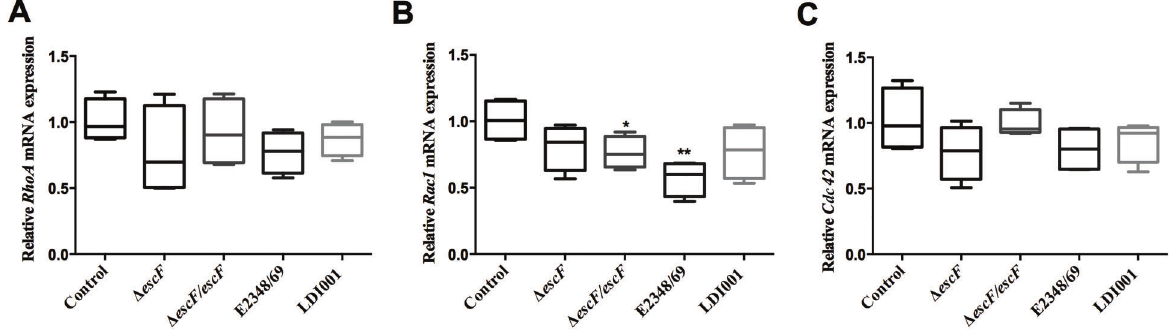
Figure 4. Expression of the transcription of small Rho GTPases RhoA ( A ), Rac1 ( B ), and Cdc42 ( C ) by IEC-6 cells after infection with enteropathogenic Escherichia coli (EPEC) strain E2348/69, EscF-complemented ( D escF / escF ) and T3SS-deletion mutant ( D escF). Results were determined by quantitative RT-PCR and normalized to ywhaz (housekeeping gene) and were performed by the DD CT method. Data are reported as means ± SE of three independent experiments. *P o 0.05 and **P o 0.01 vs uninfected control (ANOVA followed by Bonferroni ’ s